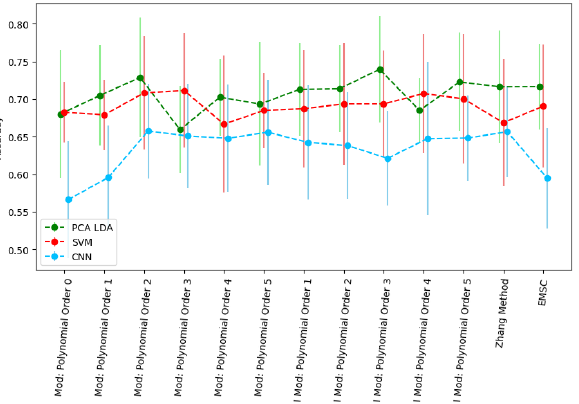
Figure A1. Model Accuracy by baseline correction method: Lynch dataset. Mean value over 15 folds and +/ − 1 SD